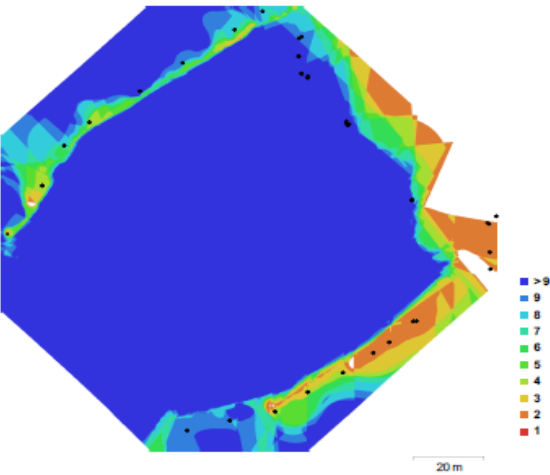
Figure 4.Camera locations and image overlap